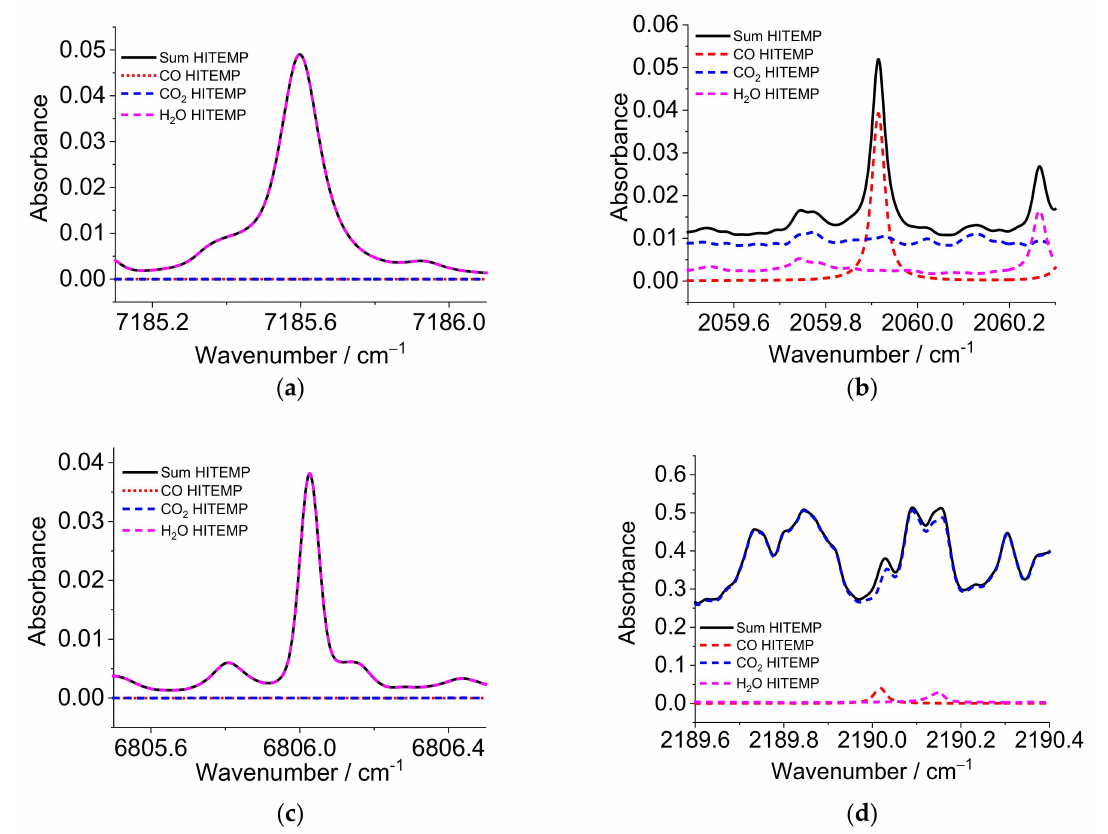
Figure 1. Simulated absorbance spectra for each of the four wavelength ranges used at 1.01 bar, 2000 K, 0.1% CO, 8% CO 2 , 18% H 2 O mole fraction with an optical path length of 60 mm for the spectral regions near 7185.59, 6806.03, 2059.91, and 2190.02 cm − 1 , respectively. The NIR spectra ( a , c ) consist of several water absorption lines, and each spectrum is dominated by a single strong transition. The MIR spectrum ( b ) is dominated by an isolated CO transition that builds on a CO 2 and water background. MIR spectrum ( d ) consists mainly of several CO 2 absorption lines, with some overlap of isolated CO and water transitions. The large number of CO 2 absorption lines in this region and their superposition results in a significant baseline for the CO